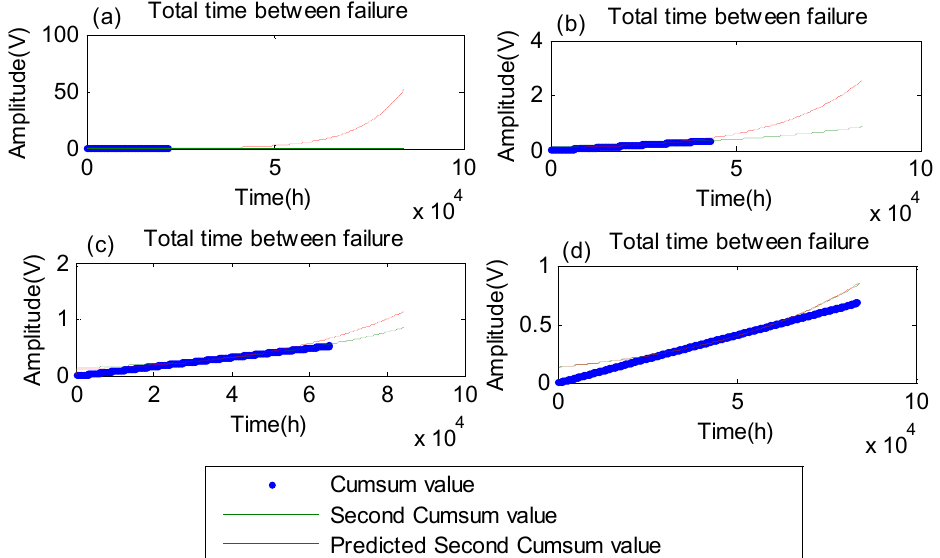
Figure 8. The RUL prognostics results with the amplitude of the accumulative signal utilizing grey theory: ( a ) prognostics result based on 25% of the accumulative data; ( b ) prognostics result based on 50% of the accumulative data; ( c ) prognostics result based on 75% of the accumulative data; ( d ) prognostics result based on 100% of the accumulative data.